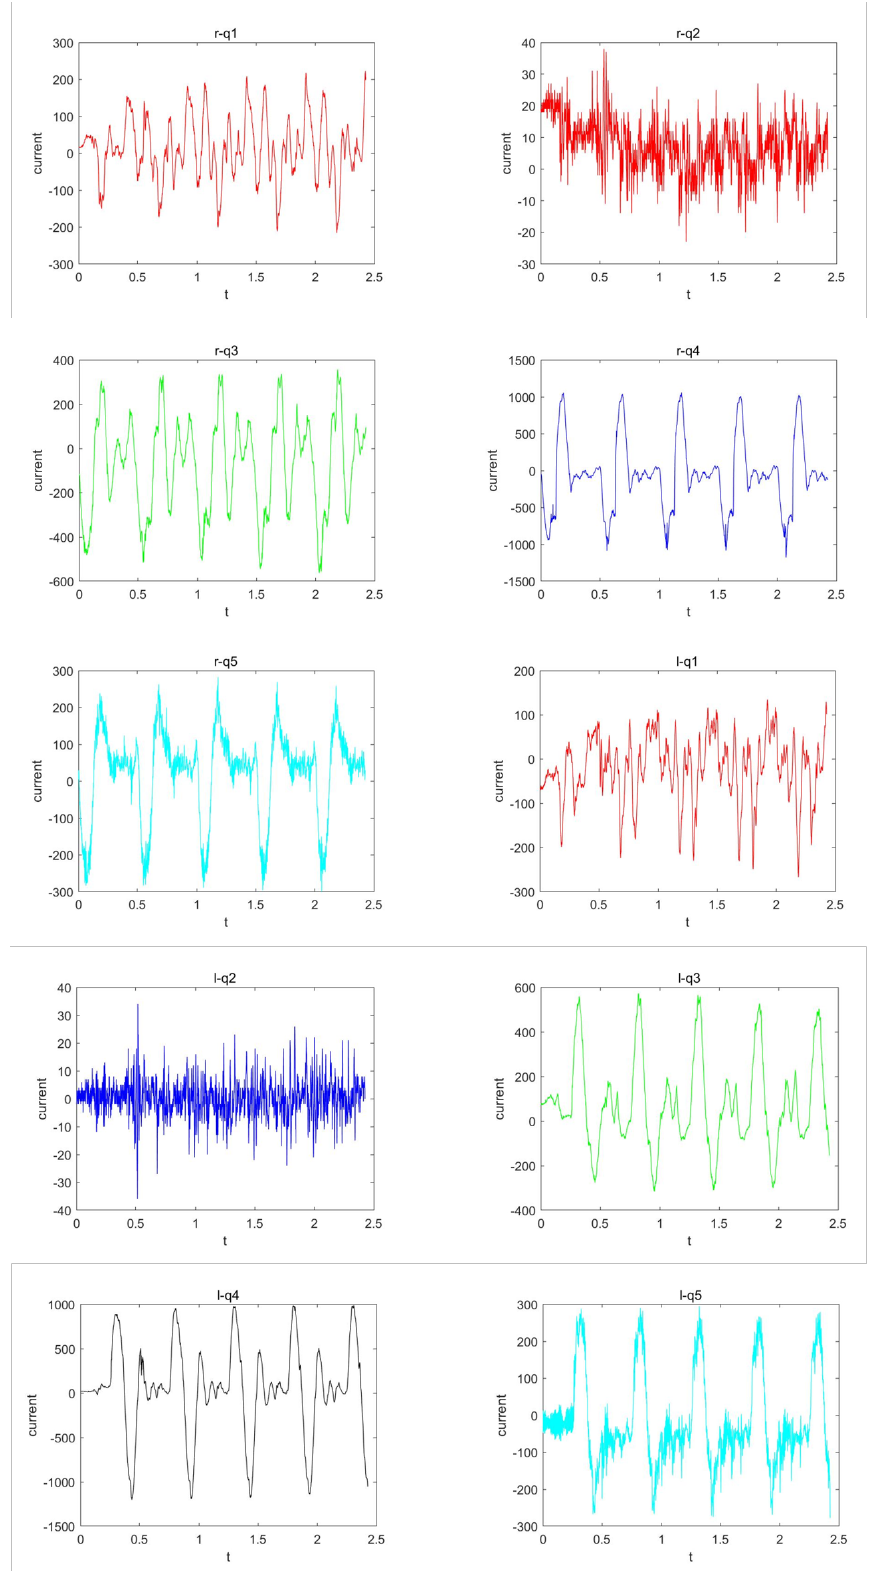
Figure 11. Experiment data. When the trapezoidal trajectory speed is 8 mm/MS, this is the motor current data collected by the robot motion. It can be seen from the figure that when the robot moves at the current speed, it approaches the performance limit of the motor, and even has a short-term current